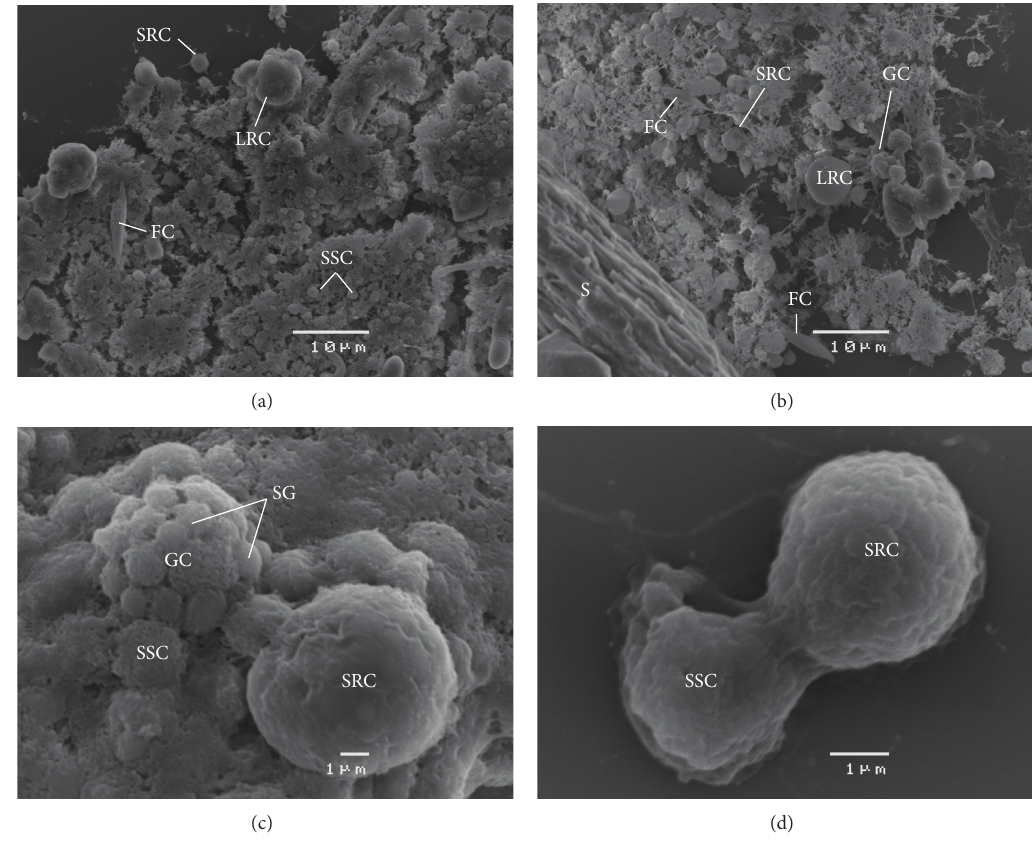
Figure 6: Acanthaster planci. Scanning electron micrographs of clusters formed 6 hours after injection. Fusiform cell (FC), granulocyte (GC), large rounded cell (LRC), salt crystal (S), secretory granule (SG), small rounded cell (SRC), and small spherule cell